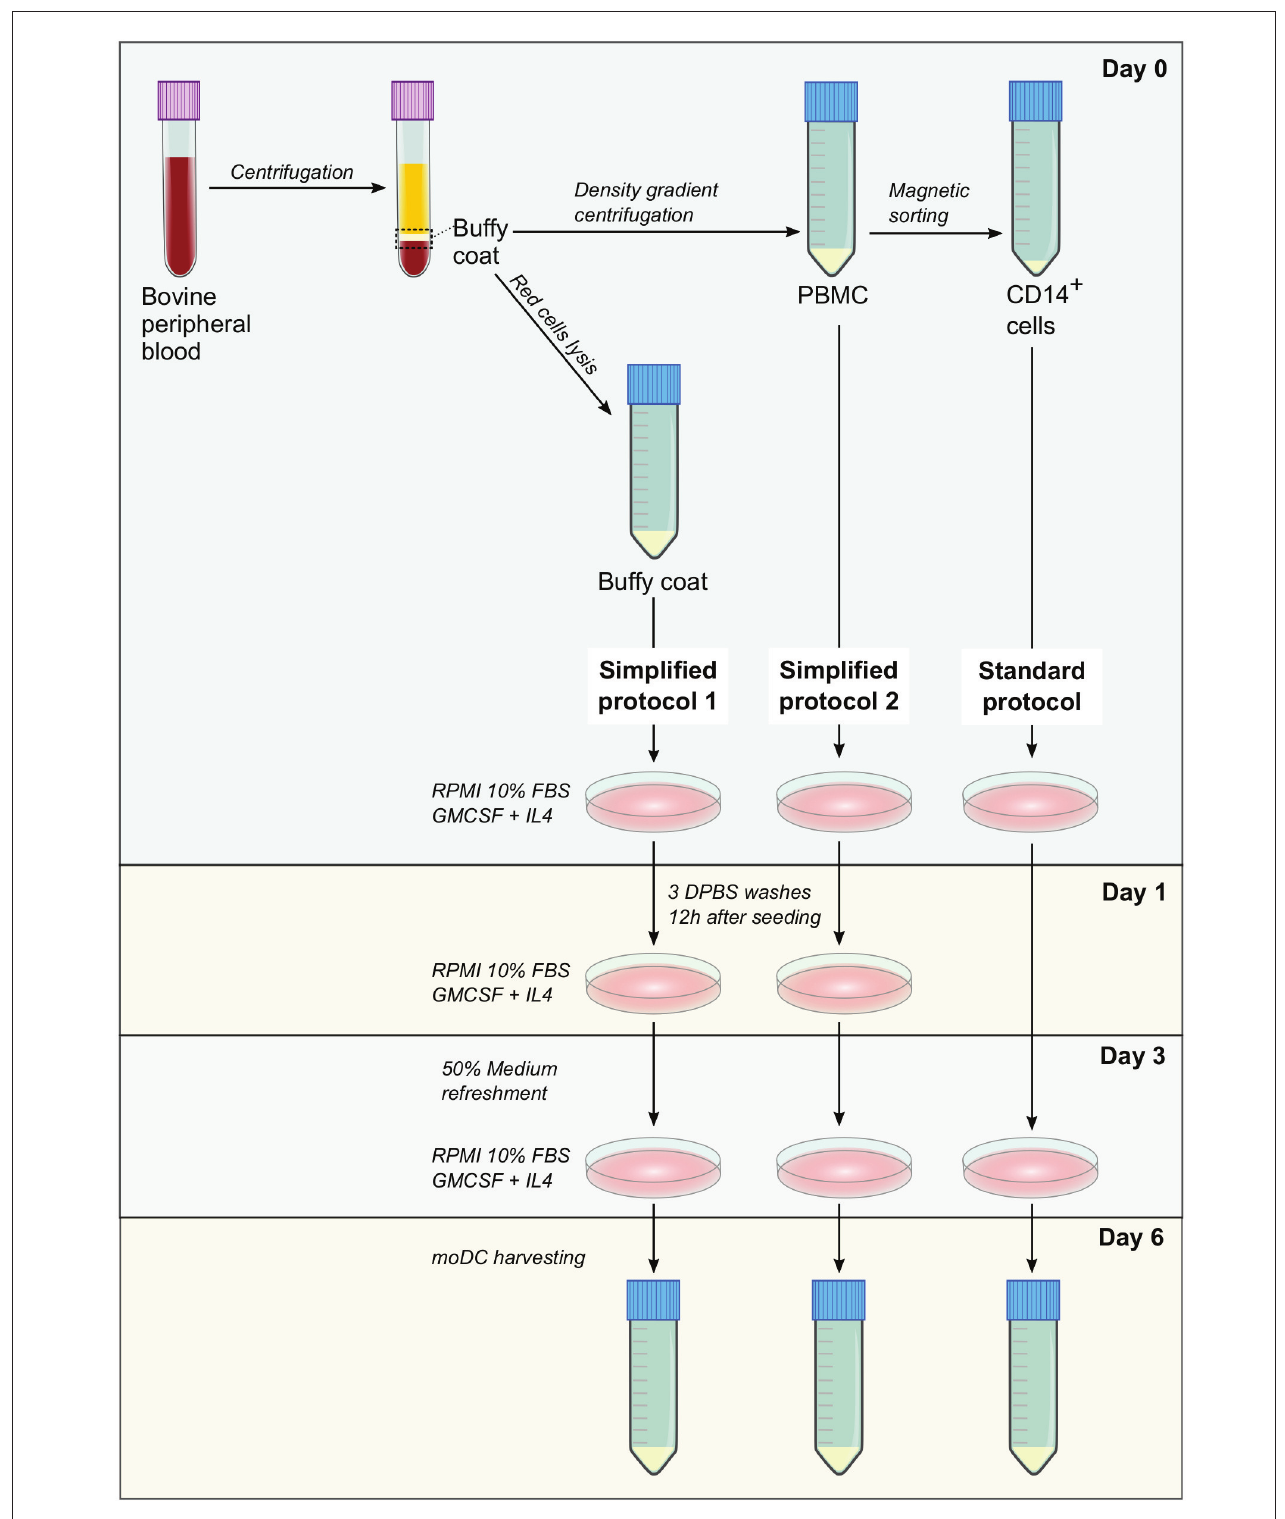
FIGURE 1 | Methods for the production of bovine monocyte-derived dendritic cells (moDCs). In simplified protocols 1 and 2, buffy coat and peripheral blood mononuclear cells (PBMC) from ethylenediaminetetraacetic acid (EDTA)-treated whole blood are used as precursor cells for the derivation of moDCs, respectively. Non-adherent cells are washed out 12h after seeding and after medium refreshment at day 3, moDCs are harvested at day 6. In standard protocol, moDCs are produced from CD14 + cells sorted from PBMC. After medium refreshment at day 3, moDCs are harvested in day 6.